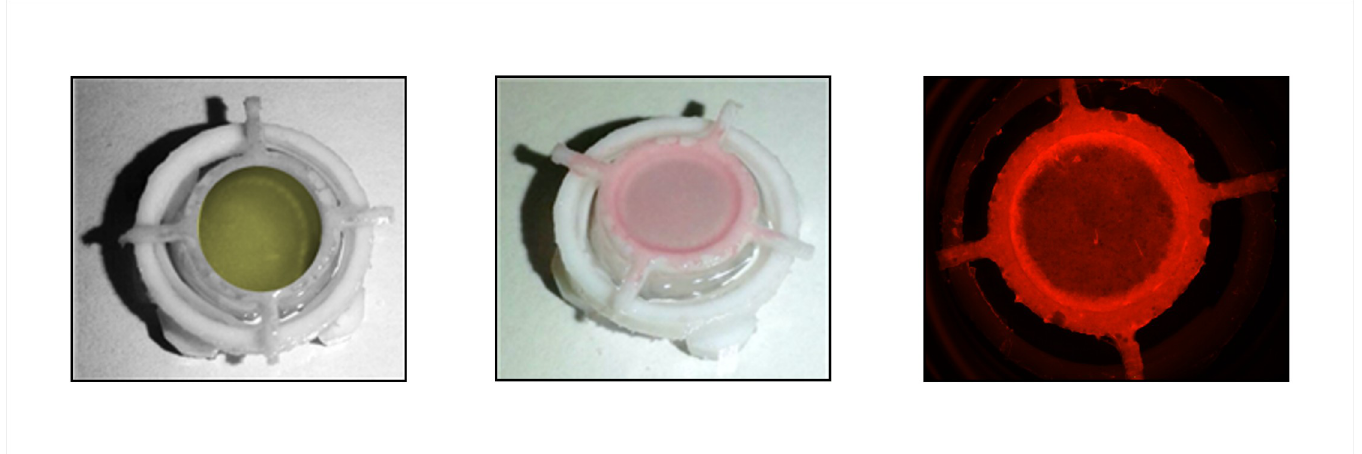
Fig 1. Ring constructs at different stages of production/culture. Left: Early culture in Differentiation Medium showing the Teflon ring and support (brightfield). Middle: Late culture after incubation in Mineralization Medium containing ARS and beta-glycerol phosphate (brightfield). Right: Late culture showing ARS fluorescence from a Daily PEMF-treated ring (exposure adjusted to reveal variation in intensity).